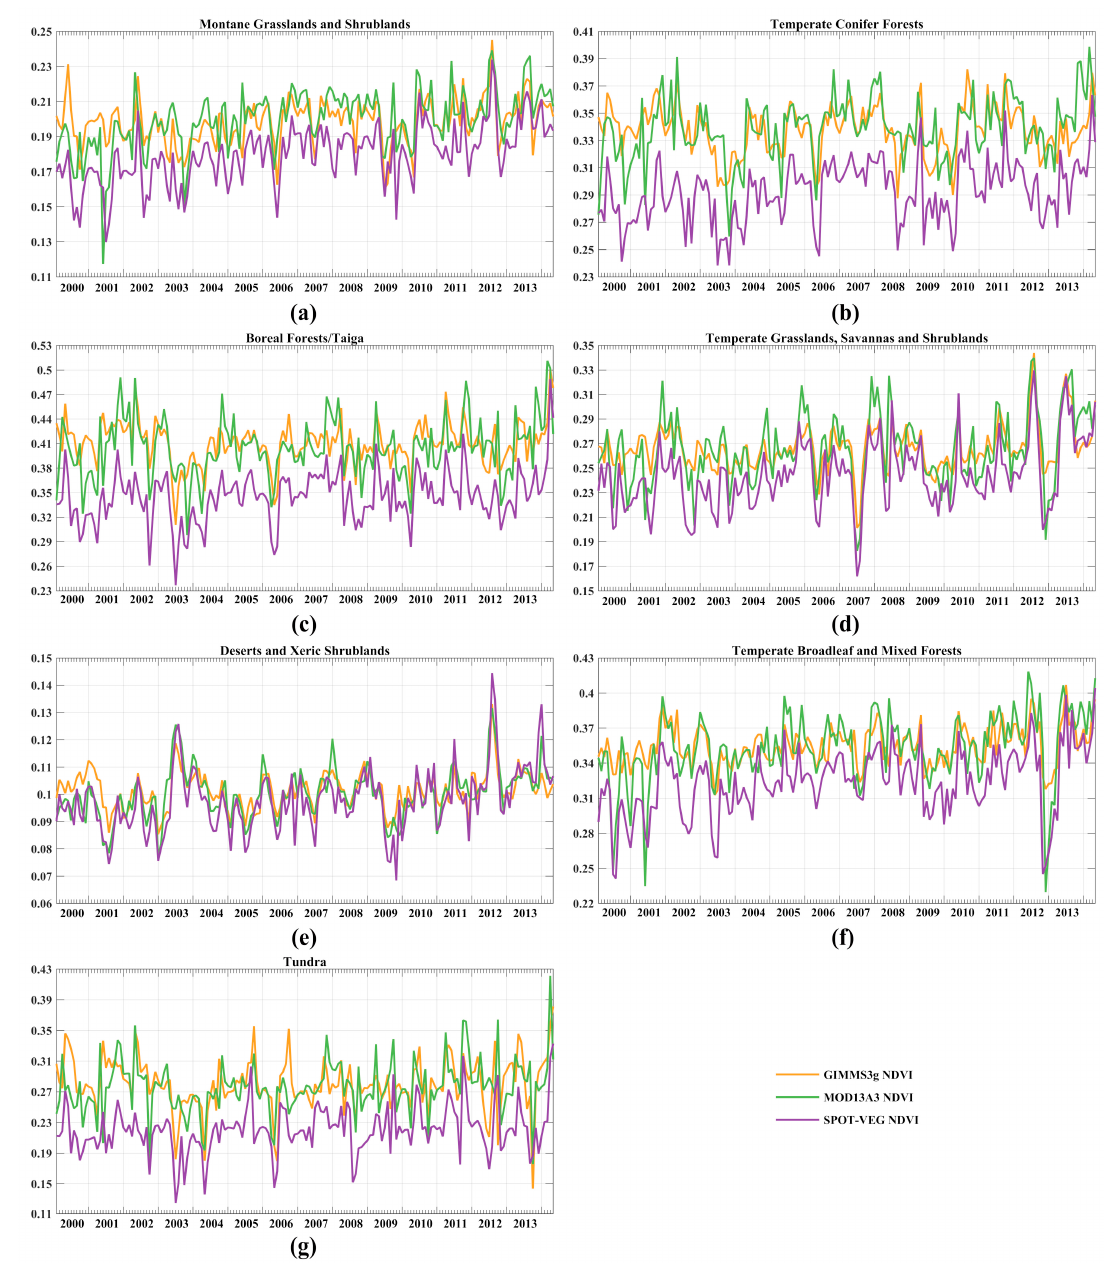
Figure 7. Time series of deseasonalized NDVI values in the biomes of ( a ) montane grasslands and shrublands, ( b ) temperate conifer forests, ( c ) boreal forest/taiga, ( d ) temperate grasslands, savannas, and shrublands, ( e ) deserts and xeric shrublands, ( f ) temperate broadleaf and mixed forests and (g) tundra in the MP.